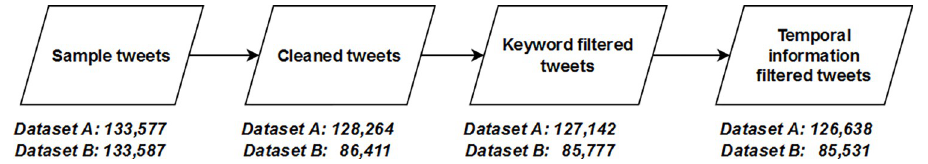
Fig 3. Number of remaining tweets for each stage of the text preprocessing. Sample tweets shows the original count of tweets in each dataset. Temporal information filtered tweets shows the remaining number of tweets after the last preprocessing